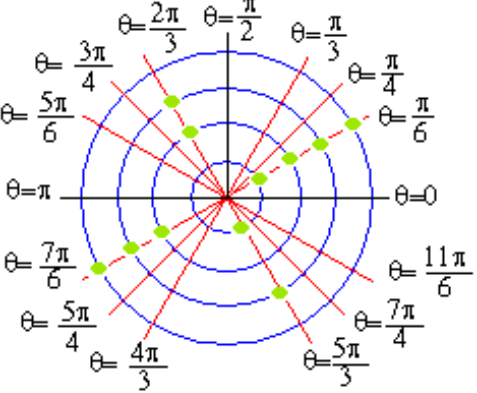
ϕ of the network of